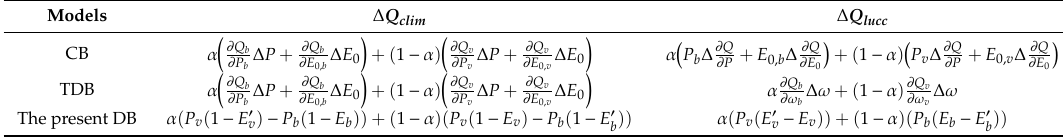
Table 1. The expressions of climate change impact ∆ Q clim and LUCC impact ∆ Q lucc for the three models.